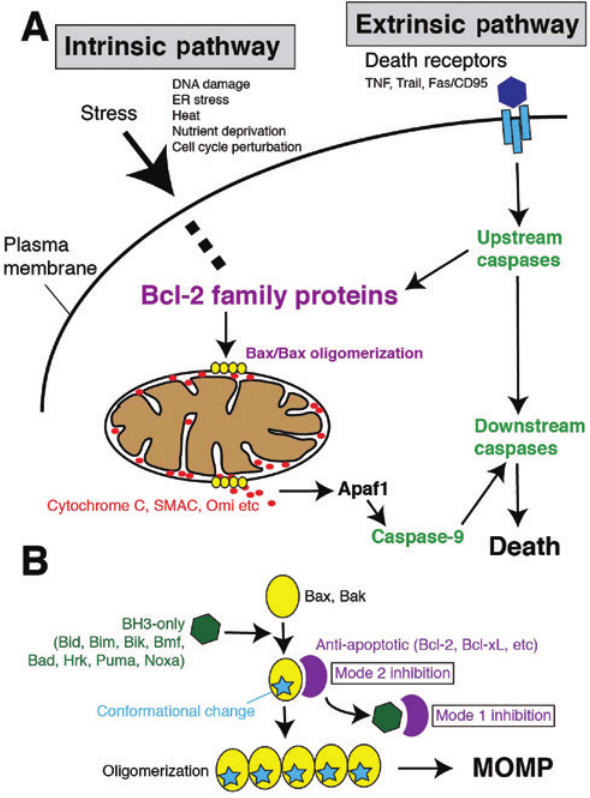
Figure 1: Mammalian apoptotic pathways and the current model for the Bcl-2 family protein function. (A) Depending on the death stimulus, apoptosis is activated through the extrinsic pathway (mediated through death receptors) or the intrinsic pathway, in which MOMP is critical. There is also crosstalk between the two pathways via Bid, one of the Bcl-2 family proteins. As a result of Bax/Bak activation and oligomerization in the mitochondrial outer membrane, mitochondria release intermembrane space proteins (cytochrome C, SMAC, or Omi/HTRA2), which leads to activation of caspases. (B) Current model of how Bcl-2 family proteins regulate MOMP. Effector proteins, Bax and Bak, undergo conformational change when activated by BH3 domain-only proteins and oligomer- ize at the mitochondrial outer membrane to permeabilize it. Anti- apoptotic members can inhibit MOMP by sequestering BH3-only proteins (mode 1 inhibition [2]) and/or activated Bax/Bak (mode 2 inhibition